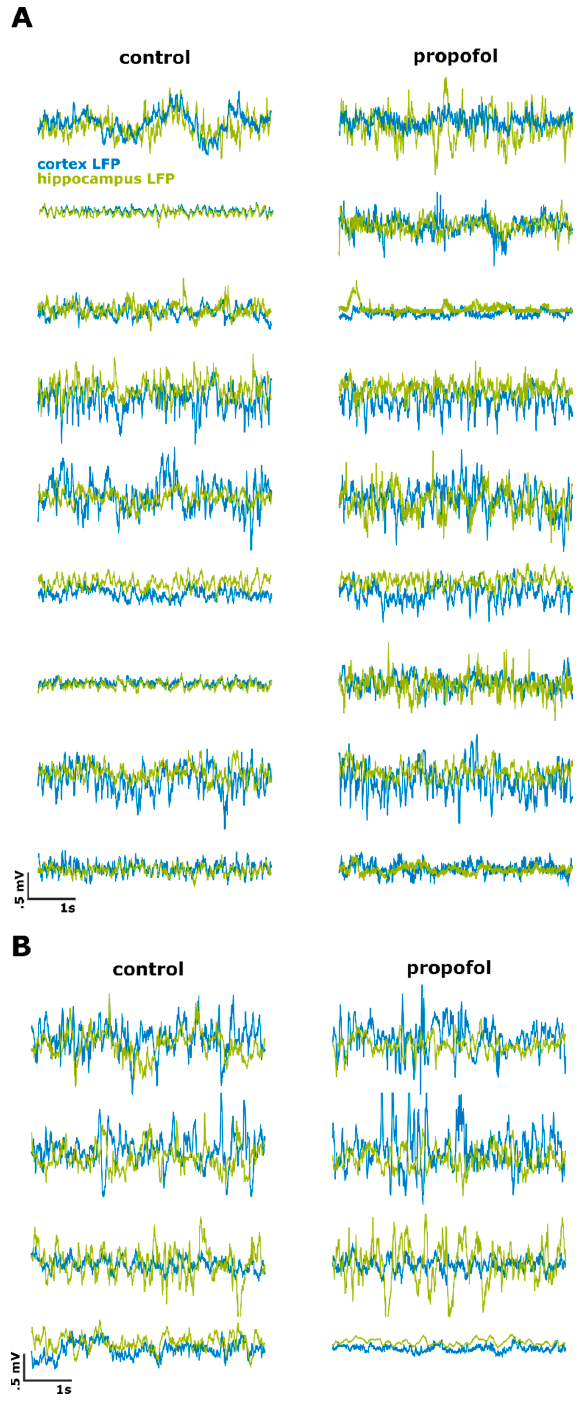
Figure A1. Prefrontal cortical (blue) and hippocampal (green) LFP episodes of 5 s used for analysis: ( A ) episodes derived from the wild types, ( B ) episodes derived from β 3(N265M) mutants. LFP: local field potential.